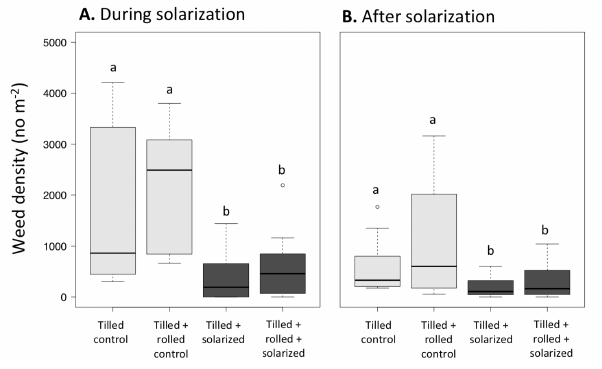
Figure 1. Mean cumulative weed density (A) during so- larization and (B) after solarization across experimental site-years and on-farm trials. Means were separated by Fisher’s Protected LSD.